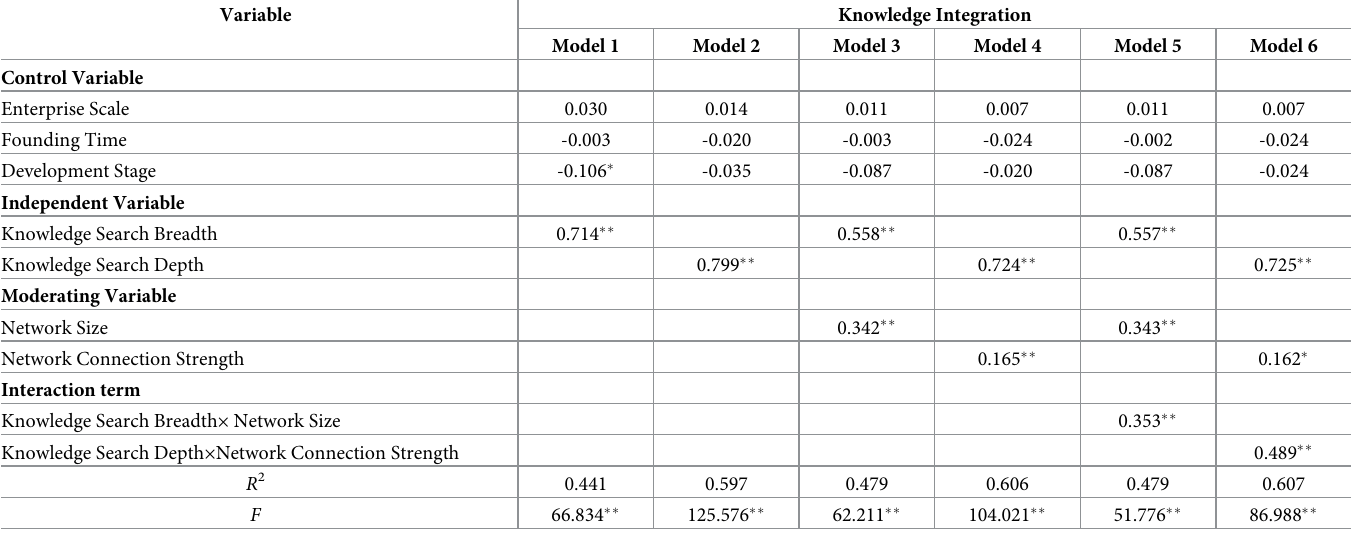
Table 8. The moderating effect test of innovation ecosystem network